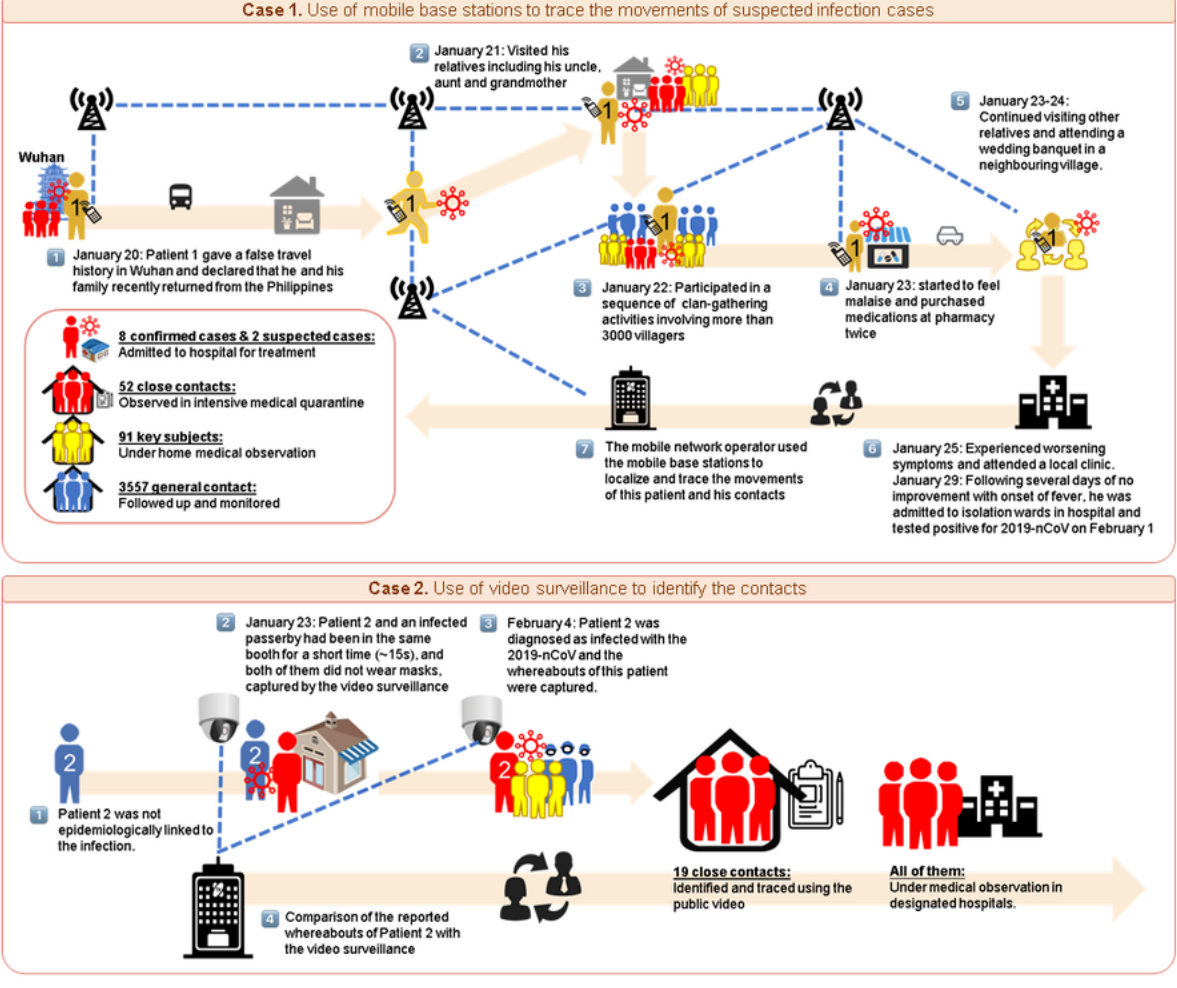
Figure 2. The application of digital epidemiology in the outbreak of COVID-19. Case 1: Use of mobile base stations to trace the movements of suspected infection cases. Case 2: Use of video surveillance to identify the